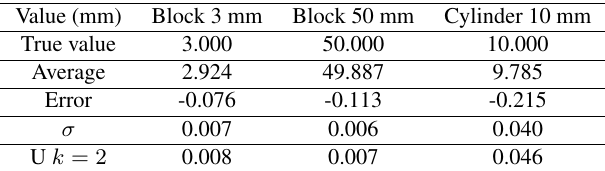
Table 4. Results of Shape from Contour Technique.